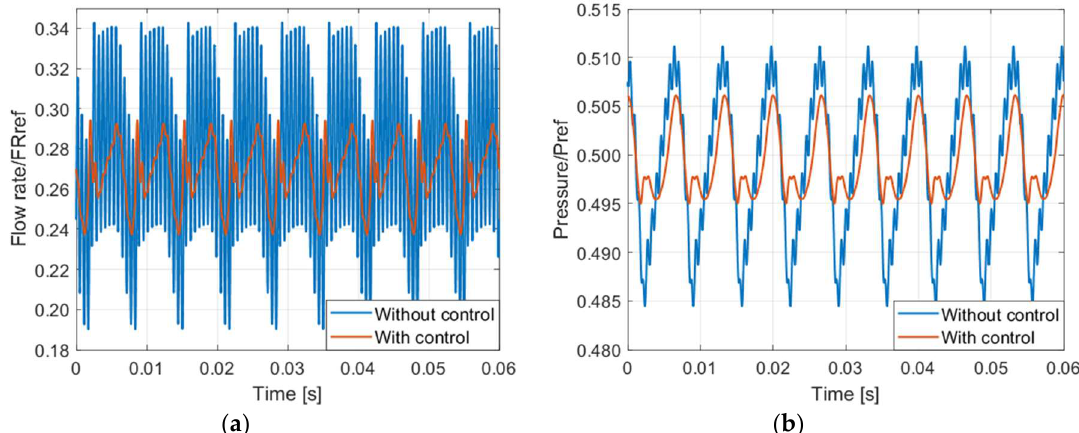
Figure 18. Real pump model with higher spring stiffness. Swash plate position. Shaft speed 1000 r/min.